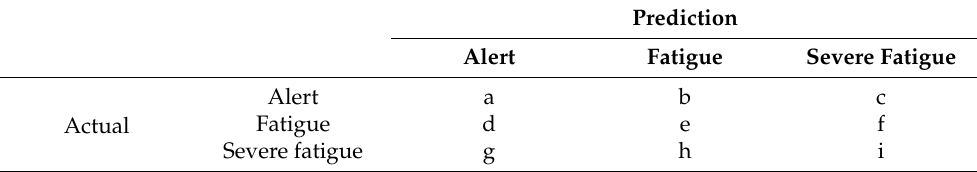
Table 3. Confusion